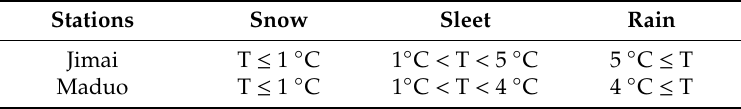
Table 1. Critical temperature of snow, sleet, and rain.